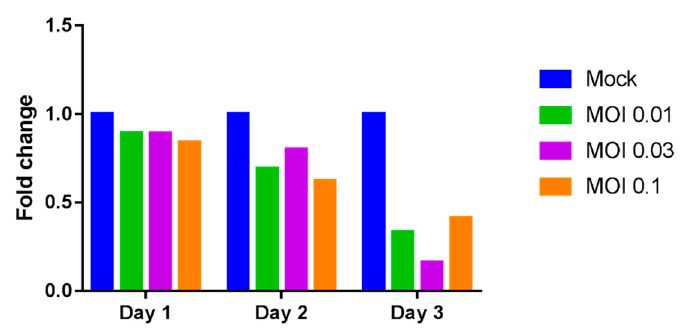
Figure 2. Relative expression of LGALS9 mRNA. THP-1 cells were mock-infected or infected with DENV-3 at varying doses. Cells were incubated and harvested after 1, 2 and 3 days post-infection. Total RNA from cell lysates was extracted and reverse transcription quantitative RT-PCR was used to determine the expression of LGALS9 mRNA. The mRNA levels of galectin-9 (Gal-9) were normalized to GAPDH mRNA.